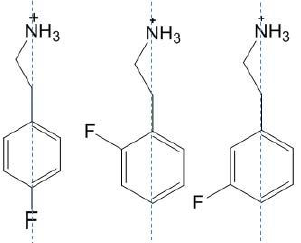
Figure 8. Schema showing the arrangement of the ammoniums in fluorinated perovskites.